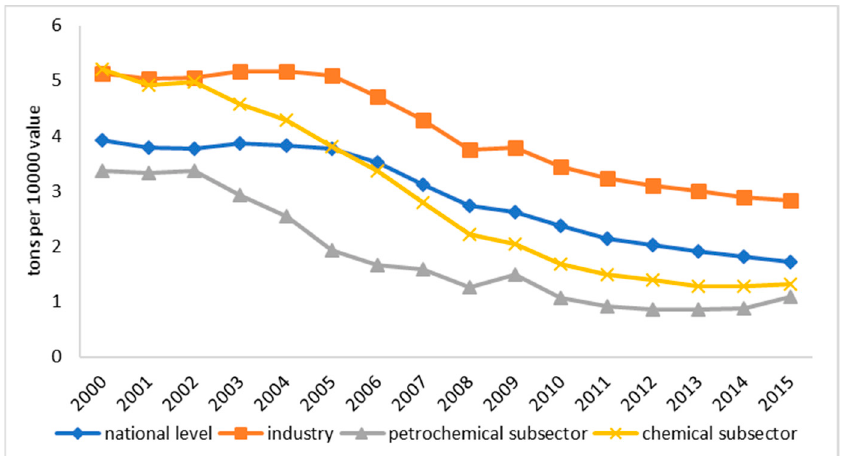
Figure 5. CO 2 emissions per 10,000 Value. CO 2 emissions per 10,000 value-added has been decreasing